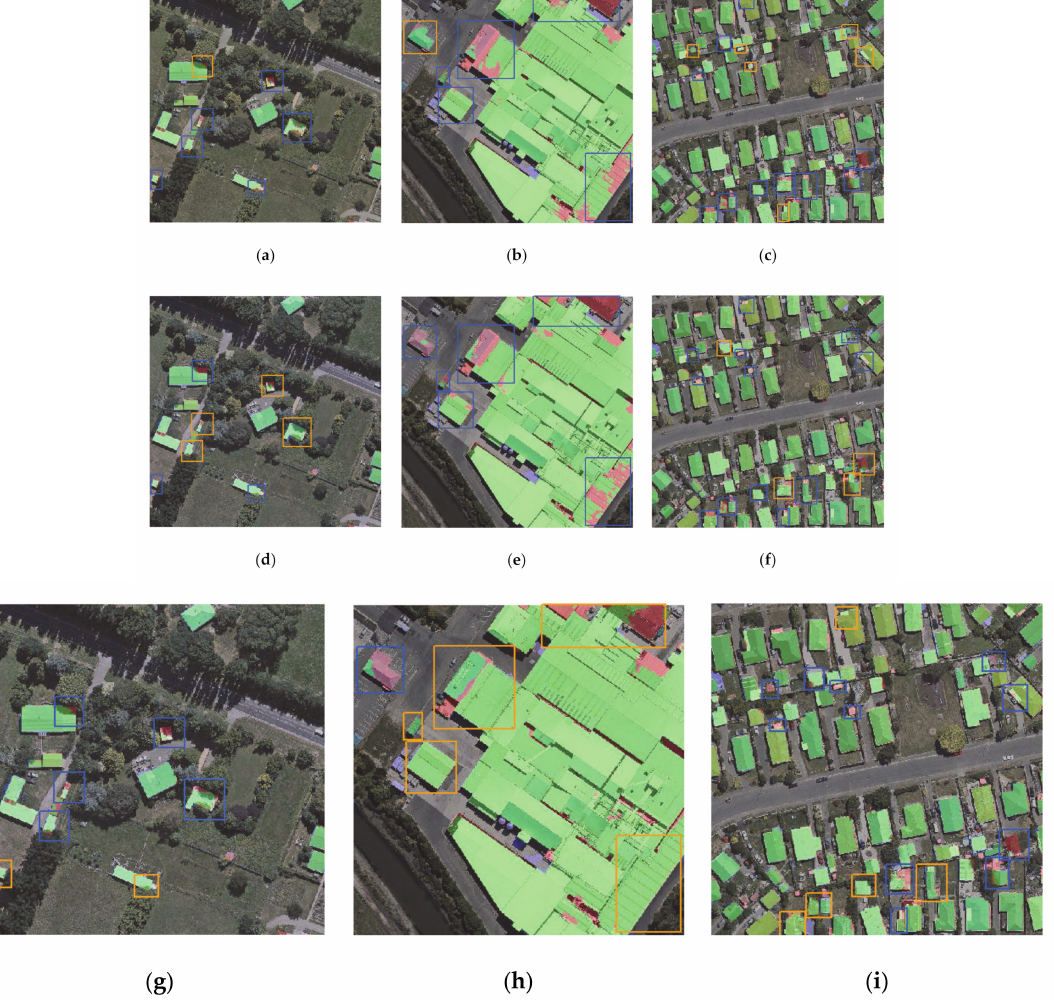
Figure 5. The performance of different networks. In the first row, ( a – c ) show the performance of BRRNet; In the second row, ( d – f ) show the performance of DeepLabv3+Net; In the third row, ( g – i ) show the performance of DR-Net. Yellow boxes represent best performance among three methods; blue boxes represent a relative worse performance among three